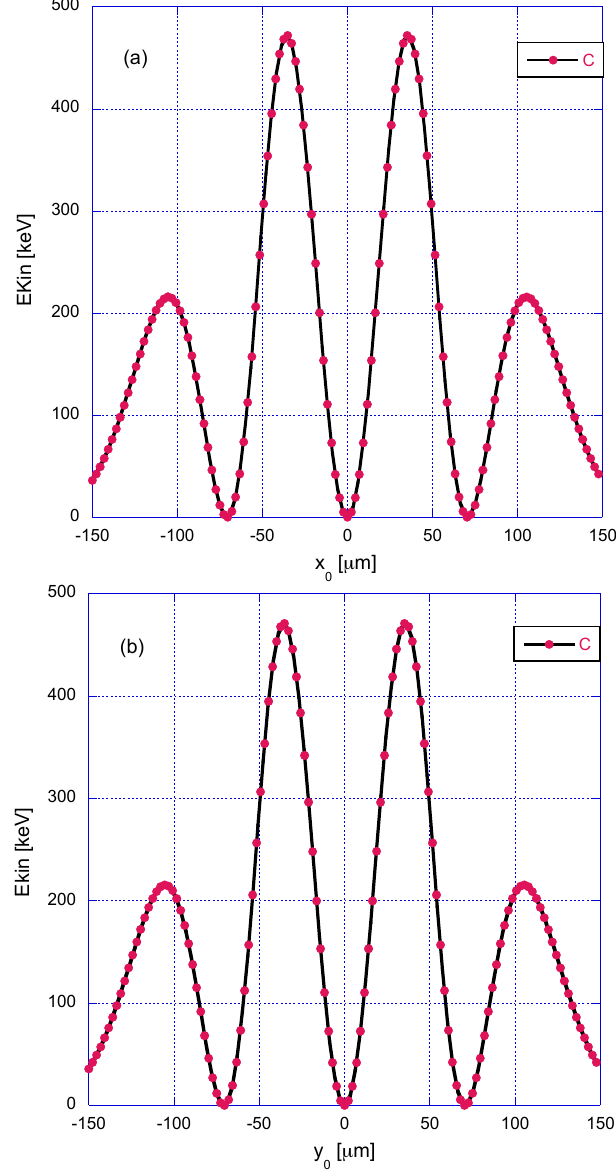
Figure 12. Asymptotic values of the kinetic energy for initial conditions of the form x 0 ∈ [ − 1.5 × w 0 , 1.5 × w 0 ] , y 0 random ∈ [ − λ 0 /2, λ 0 /2 ] , z 0 = 0 (a), and y 0 ∈ [ − 1.5 × w 0 ,1.5 × w 0 ] , x 0 random ∈ [ − λ ] , z = 0 (b). Red dots correspond to the computations, black lines are cubic spline 0 /2, λ 0 /2 0 fittings to the data. The 90 ◦ symmetry of the asymptotic kinetic energy distribution is apparent from this